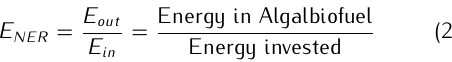
Figure 7. GC chromatogram for algal biodiesel obtained in MW pro-